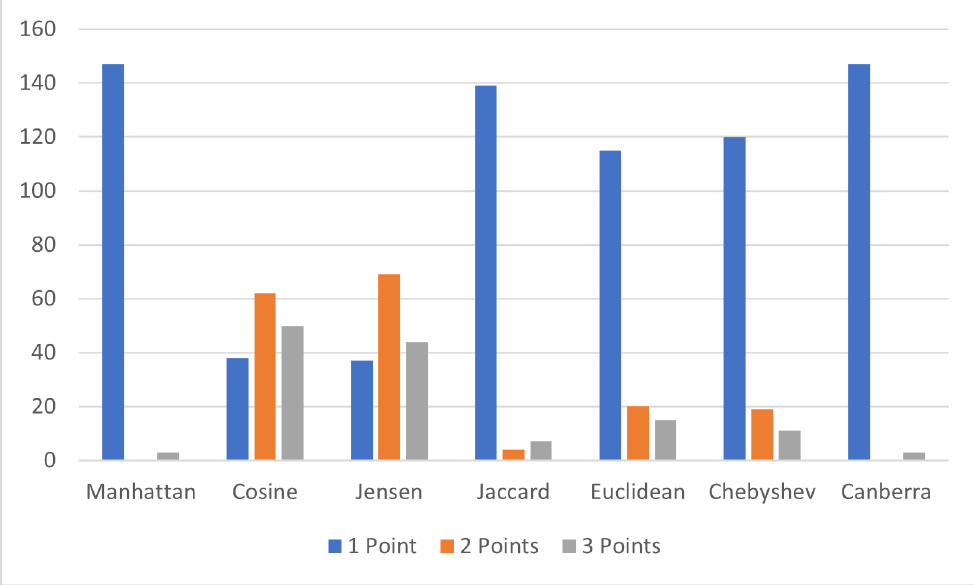
Figure 10. Human judgment results using LSA and respective similarity